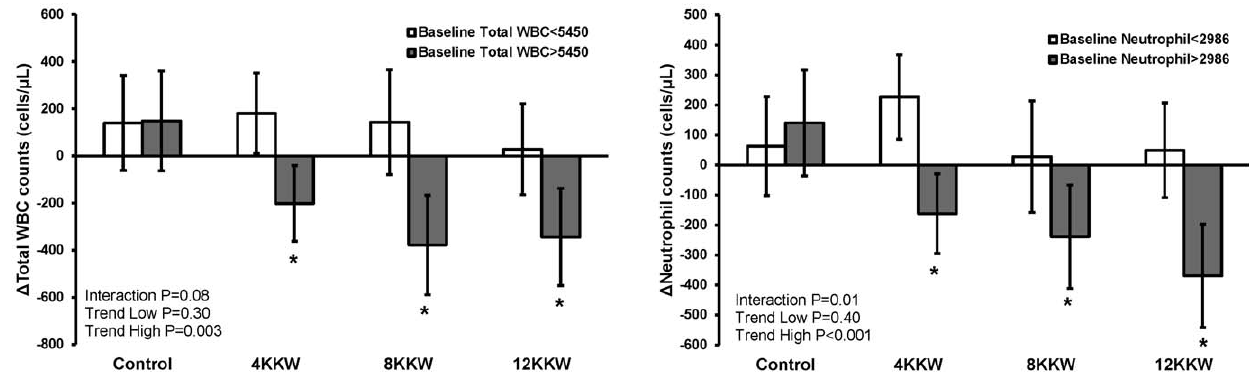
Figure 2. Change ( D ) in total WBC and neutrophil counts by exercise group (control, 4, 8, and 12 kcal kg 2 1 min 2 1 ; KKW) and high/ low baseline WBC counts. Interaction = group x high/low WBC category; trend high and low are from general linear model across intervention groups separately for each high/low baseline WBC category. The participant numbers (n) in the high baseline total WBC groups were 41, 71, 41, and 43 and low baseline total WBC groups were 45, 63, 37, and 49 for Control, 4, 8, and 12 KKW, respectively. The participant numbers (n) in the high baseline neutrophil groups were 40, 71, 42, and 42 and low baseline neutrophil groups were 46, 63, 36, and 50 for Control, 4, 8, and 12 KKW, respectively. * Significantly different between high/low baseline WBC categories within an exercise group.